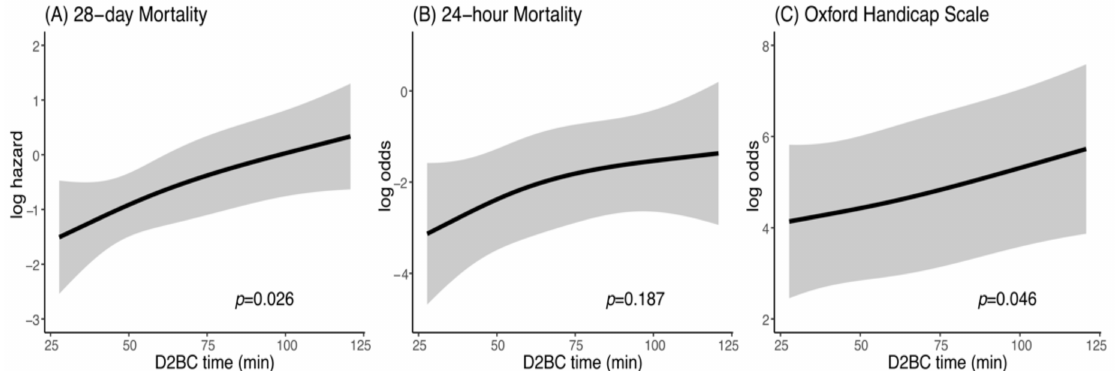
Figure 4. Effect of earlier D2BC on ( A ) 28-day mortality, ( B ) 24-h mortality, and ( C ) Oxford Handicap Scale. PH, proportional hazard; BC, bleeding control and D2BC,